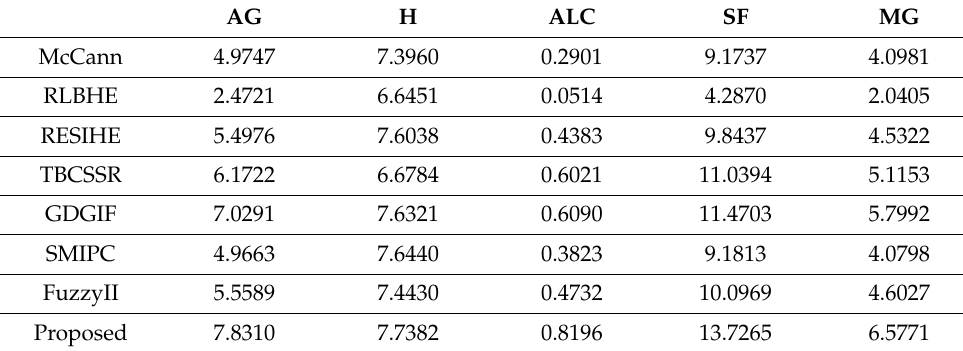
Table 4. The metric data of eight methods on X-ray image 4. AG H